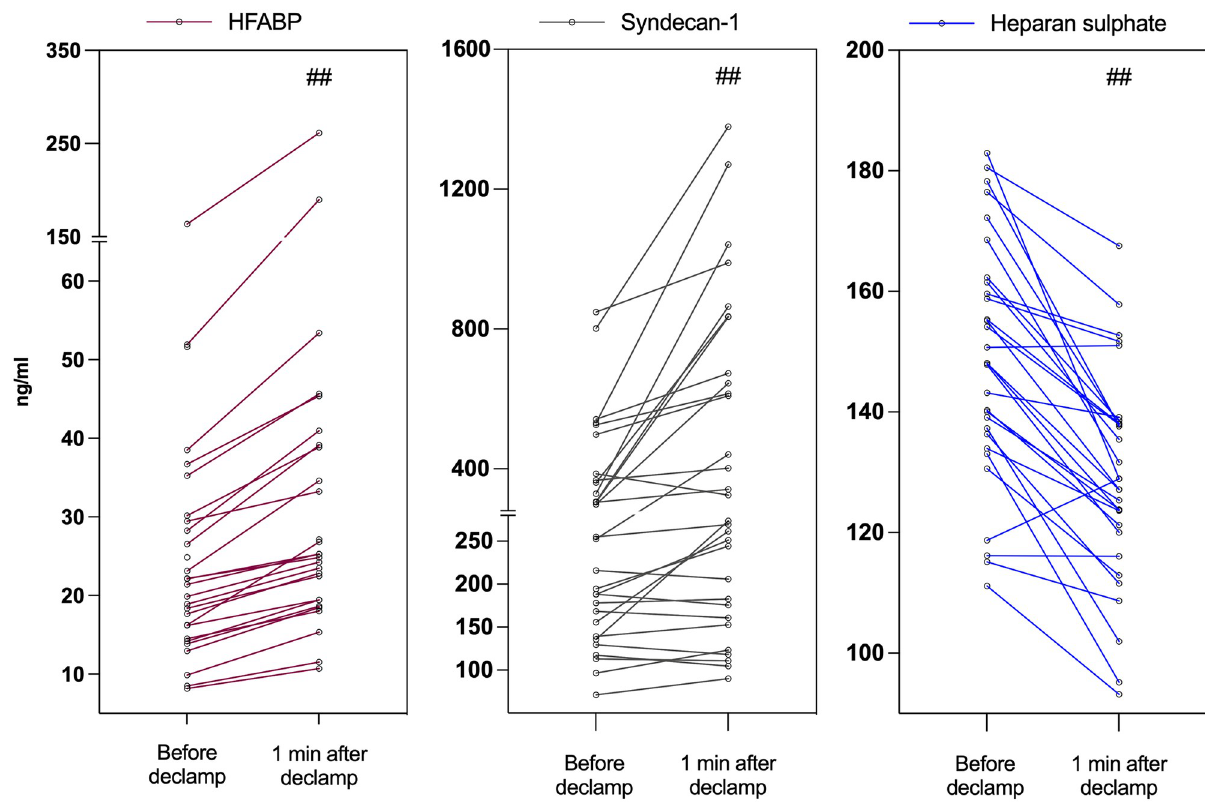
Fig 1. Systemic arterial concentrations of heart-type fatty-acid binding protein, syndecan-1 and heparan sulfate immediately before and at one minute after aortic declamping. Individual values of heart-type fatty-acid binding protein, syndecan-1 and heparan sulfate concentrations in arterial blood immediately before (Before) and at one minute after (1 min after) aortic declapmping. # p < 0.05, ## p < 0.001 for Wilcoxon signed rank test (immediately before aortic declamping vs . one minute after aortic declamping).